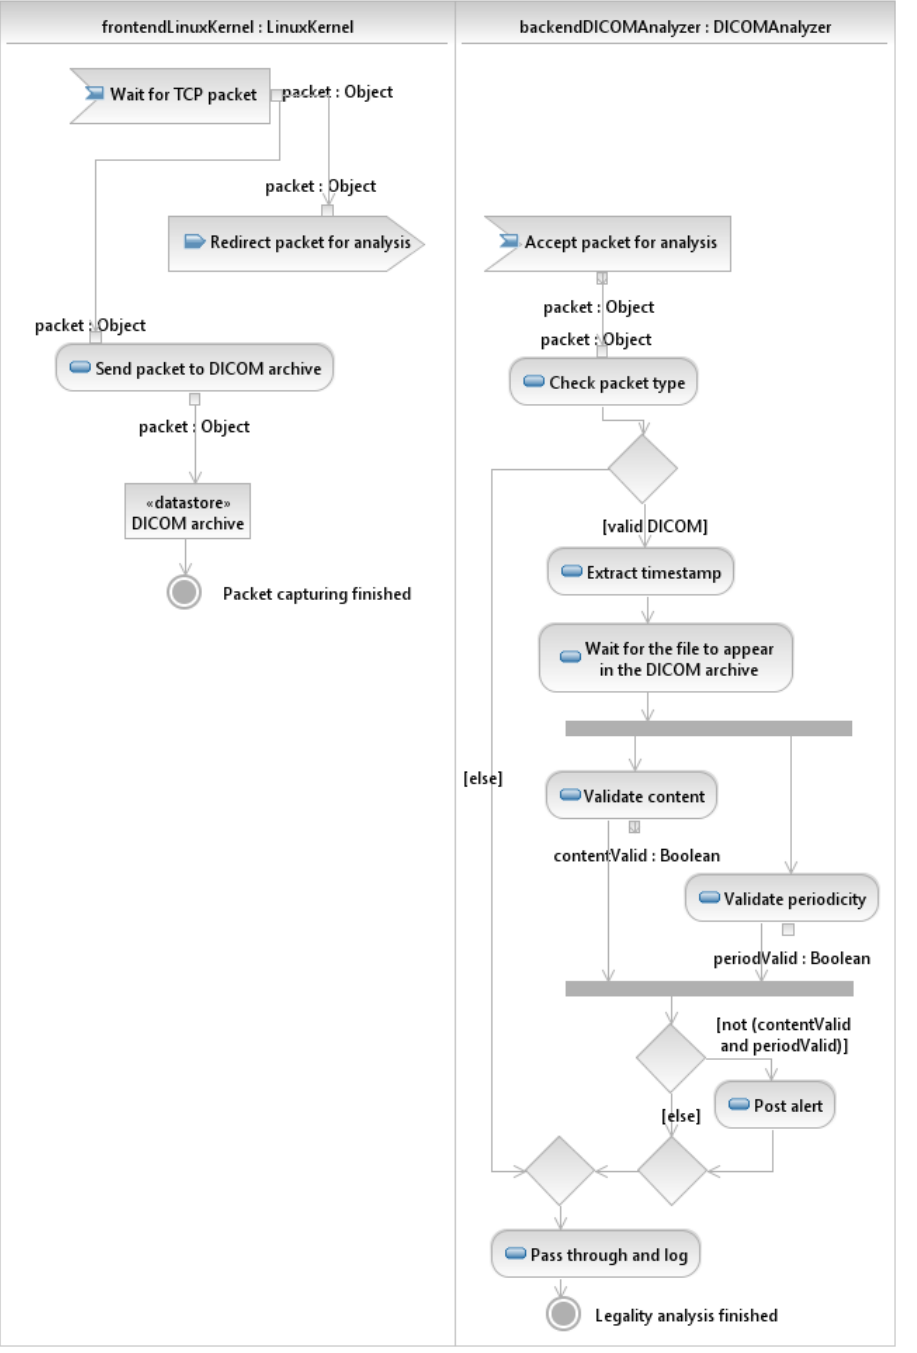
Figure 4. Analysis of incoming Digital Imaging and Communications in Medicine (DICOM) files.